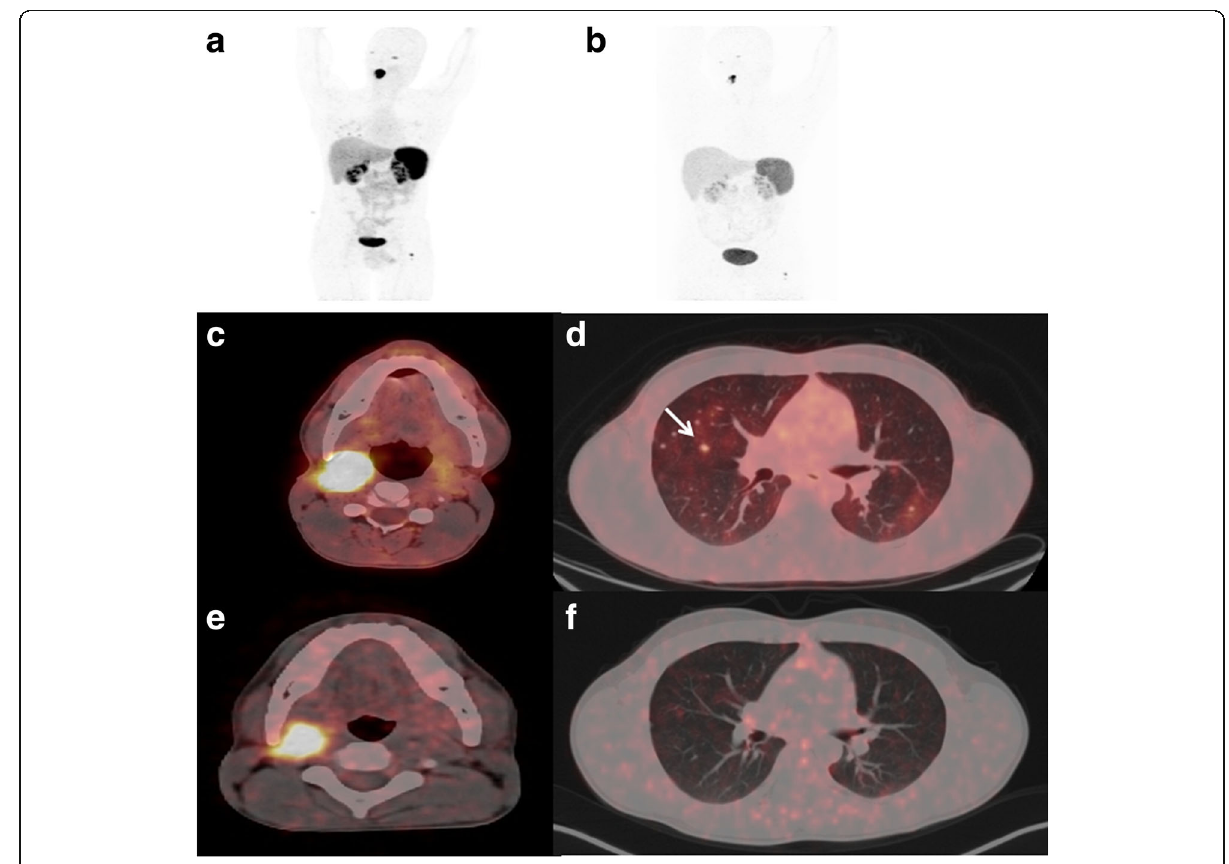
DOTANOC PET/CT scan showed somatostatin receptor (SSTR) avid soft tissue mass lesion involving the right carotid body mass measuring 2.6